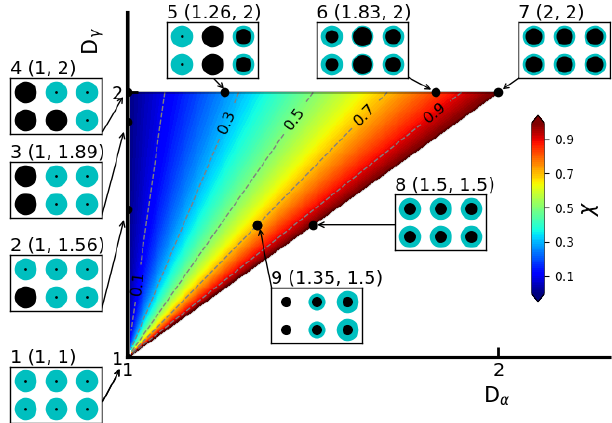
Figure 2. Mixing state diagram to illustrate the relationship be- tween D α , D γ , and χ . Each species consists of six particles, and the colors of black and cyan represent the BC and non-BC compo-